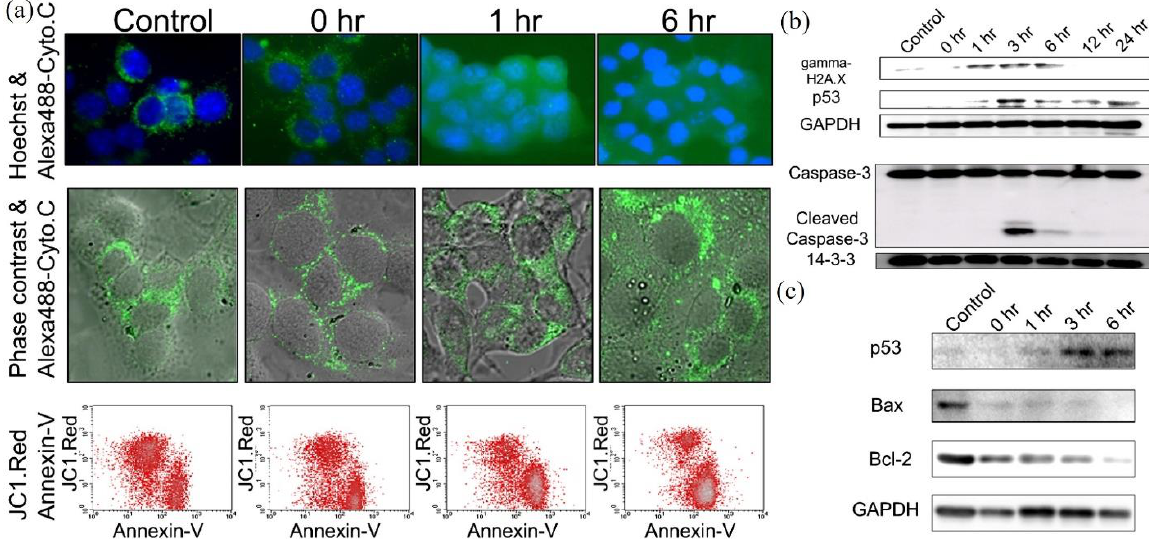
Figure 3. A typical observation of apoptosis in the CAP-treated melanoma cells B16F10. ( a ) Cellular images of cytochrome c release by immunocytochemistry and fluorescence-activated cell sorting analysis to check mitochondria membrane potential change. ( b ) Western blot analysis of the phosphorylation on serine 139 on H2AX histone ( γ -H2AX), p53, and caspase-3. ( c ) Western blot analysis of BAX and BCL − 2 [18].